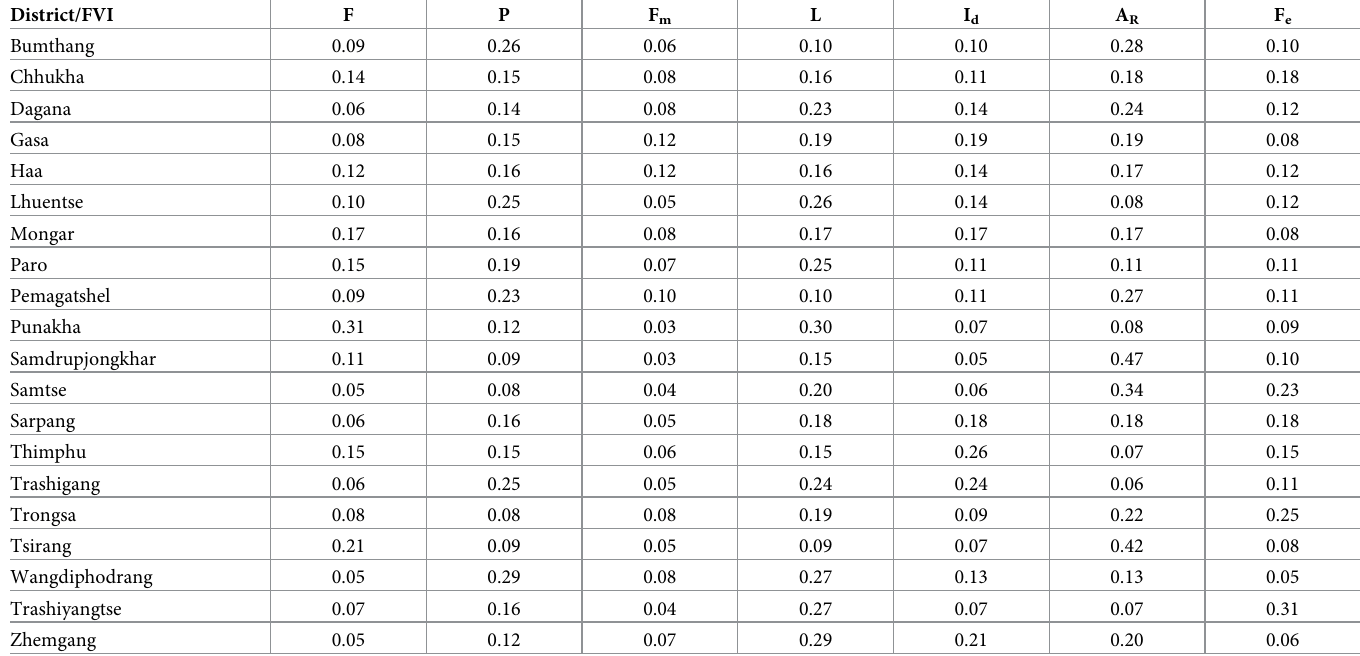
Table 9. Assigned normalised weights to DFVI indicators for 20 districts. District/FVI